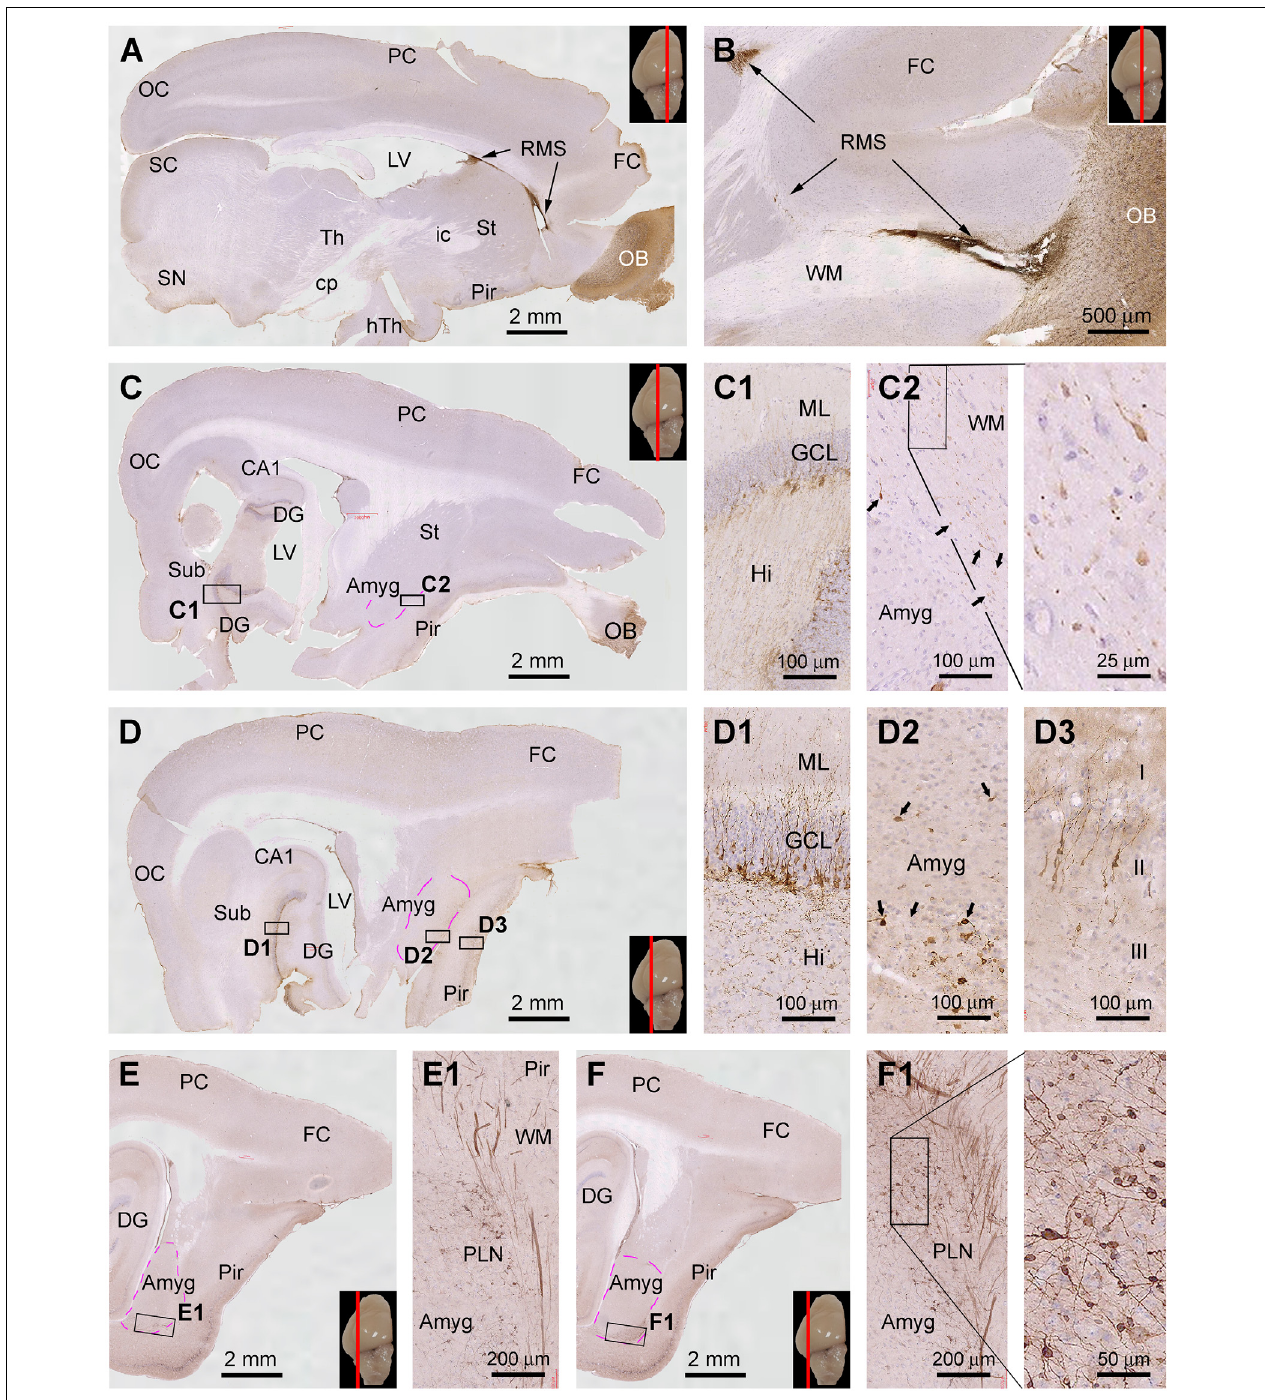
FIGURE 8 | Topographic distribution of DCX+ cellular profiles in sagittal cerebral sections from a 6-month-old animal, with hematoxylin counterstain. The approximate medial to lateral planes of the sections in reference to the top view of the brain are marked with a red line in the image panels. Framed areas in the low magnification images are enlarged as indicated. The area of the amygdalar complex (Amyg) is marked with broken purple lines (C–F) . Panels (A,B) show the immunolabeling in the subventricular zone (SVZ) forming the rostral migratory stream (RMS) extending into the olfactory bulb (OB). Panels (C,D) show the distribution of DCX+ neurons in the hippocampal dentate gyrus (DG), Amyg, and piriform cortex (Pir), with the framed areas enlarged as (C1,C2) , and (D1–D3) as indicated. Panels (E,F) are images at more lateral planes, in which the DCX+ cells in the Amyg are distinctly present in the area of the paralaminar nucleus (PLN) (E1,F1) . Additional abbreviations: FC, frontal neocortex; PC, parietal neocortex; OC, occipital neocortex; Th, thalamus; hTh, hypothalamus; St, striatum; Sub, subiculum; GCL, granule cell layer; ML, molecular layer; Hi, hilus; WM, white matter. Scale bars are as indicated.